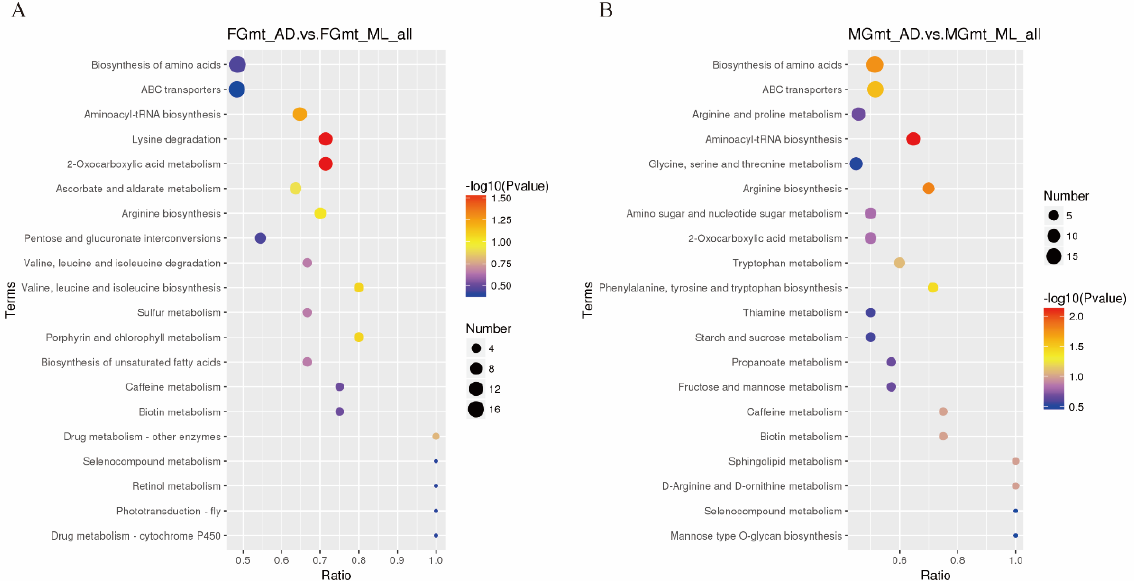
Figure 5. KEGG enrichment. ( A ) FG_AD vs. FG_ML; ( B ) MG_AD vs. MG_ML. Only the top 20 differentially enriched metabolite enrichment pathways are shown. The horizontal coordinate represents x/y (the number of differential metabolites in the corresponding metabolic pathway/the number of total metabolites identified in that pathway), with larger values indicating greater enrichment of differential metabolites in that pathway. The color of the dot represents the p -value of the hypergeometric test; the smaller the value, the more reliable and statistically significant the test is. The size of the dot represents the number of differential metabolites in the corresponding pathway; the larger the dot, the more differential metabolites are present within that pathway.